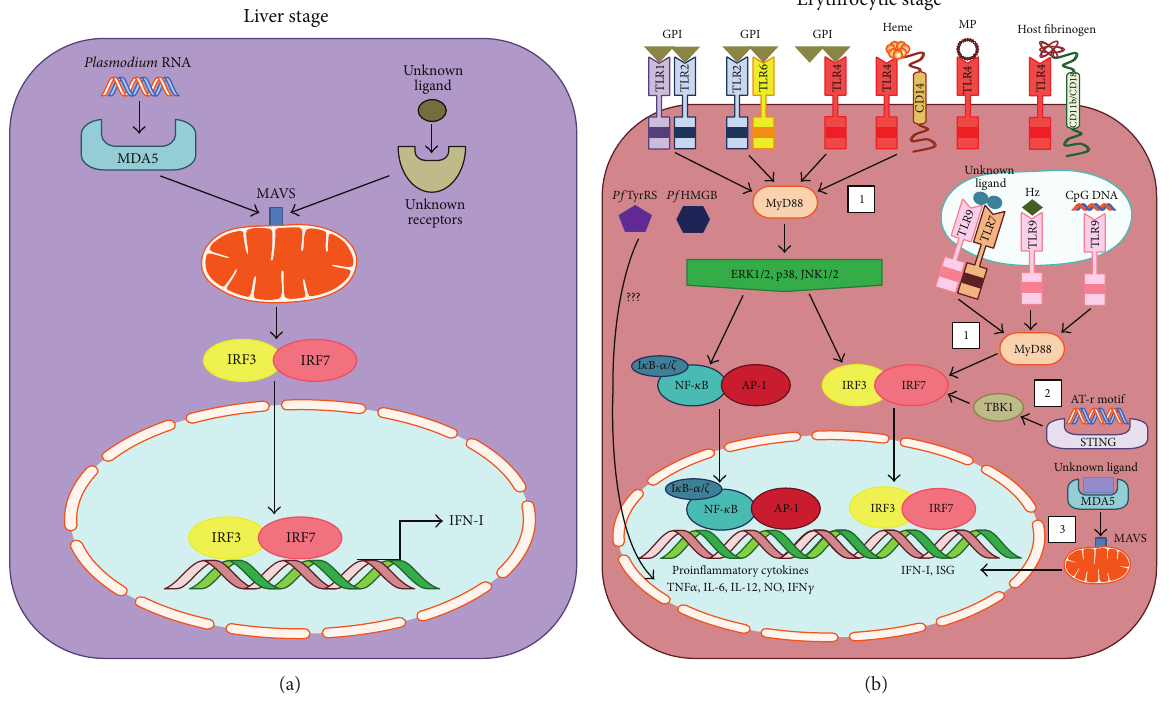
Figure 1: (a) Signaling pathway induced by malarial ligand during liver-stage infection. Plasmodium RNA is recognized by MDA5 (melanoma differentiation-association protein 5) present in the cytoplasm. Ligand-receptor interaction triggers assembly of MAVS (mitochondrial antiviralsignalingprotein)thataggregateonthesurfaceofmitochondria.ThiseventuallyleadstotheactivationofbothIRF-3andIRF-7which regulate transcription of IFN-I. Besides MDA5, activation of other receptors can also trigger aggregation of MAVS. However, this specific receptor and its corresponding malarial ligand have yet to be identified. (b) Signaling pathway induced by malarial ligand during erythrocytic- stage infection. Surface TLR4 recognizes a number of malarial ligands such as GPI (glycosylphosphatidylinositol membrane anchor) and MP (microparticles).TogetherwithCD14orCD11b/CD18integrin,itcanrecognizehemeandhostfibrinogen,respectively.BothTLRheterodimer TLR1/TLR2 and TLR2/TLR6 recognize GPI. Within the endosomal compartment, Hz (Hemozoin) and CpG DNA are recognized by TLR9. In addition, TLR7/TLR9 heterodimer has been proposed to recognize an unknown malarial ligand. These ligand-receptor interactions trigger 3 proposed pathways. (1) TLR-dependent pathway involves the recruitment of MyD88 (myeloid differentiation primary gene 88) to TLR, which phosphorylates downstream MAPKs (mitogen-activating protein kinases), such as ERK1/2 (extracellular-signal-regulated kinases 1/2), p38 MAPK, and JNK1/2 (c-Jun N-terminal kinases 1/2). Subsequently, NF- 𝜅 B (nuclear factor kappa-light-chain-enhancer of activated B cells) and AP-1 (activating protein-1) translocate into the nucleus and stimulate production of proinflammatory cytokines. At the same time, phosphorylated MAPKs or MyD88 can induce activation of IRF-3 and IRF-7 to transcribe IFN-I and ISGs (interferon stimulated genes). (2) Activation of TLR-independent pathway triggered by AT-rich motif present in the plasmodial genome engages STING, TBK, IRF-3, and IRF-7. (3) Another TLR-independent pathway involves MDA5 and MAVS. Pf TyrRS ( P. falciparum tyrosyl-tRNA synthetase) and Pf HMGB ( P. falciparum high mobility group box protein) were shown to induce proinflammatory responses but the exact signaling pathways have yet to be